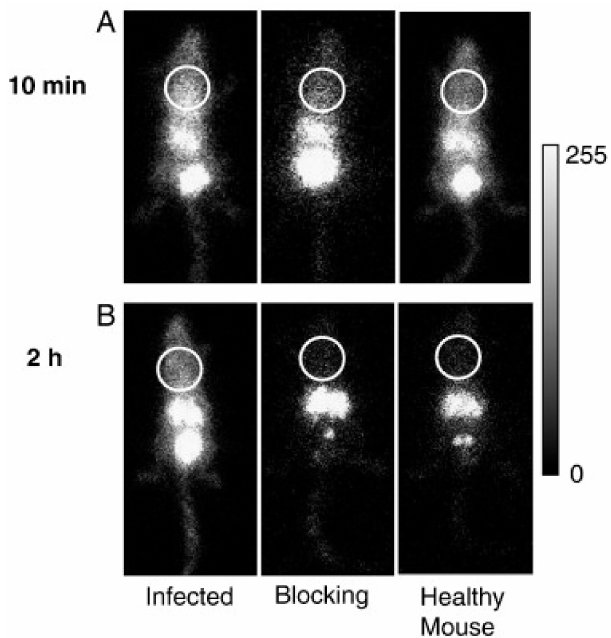
Figure 2. Preclinical γ -scintigraphic imaging of aspergillosis. Images of an infected mouse, a mouse co-injected with unlabelled peptide and a healthy control mouse, acquired ( A ) 10 min and ( B ) 2 h after intravenous injection of 111In-DTPA-c(CGGRLGPFC)-NH2. Circles indicate the chest area encompassing the lungs. Adapted with permission from Yang et al. Nucl. Med. Biol. 2009, 36 ,